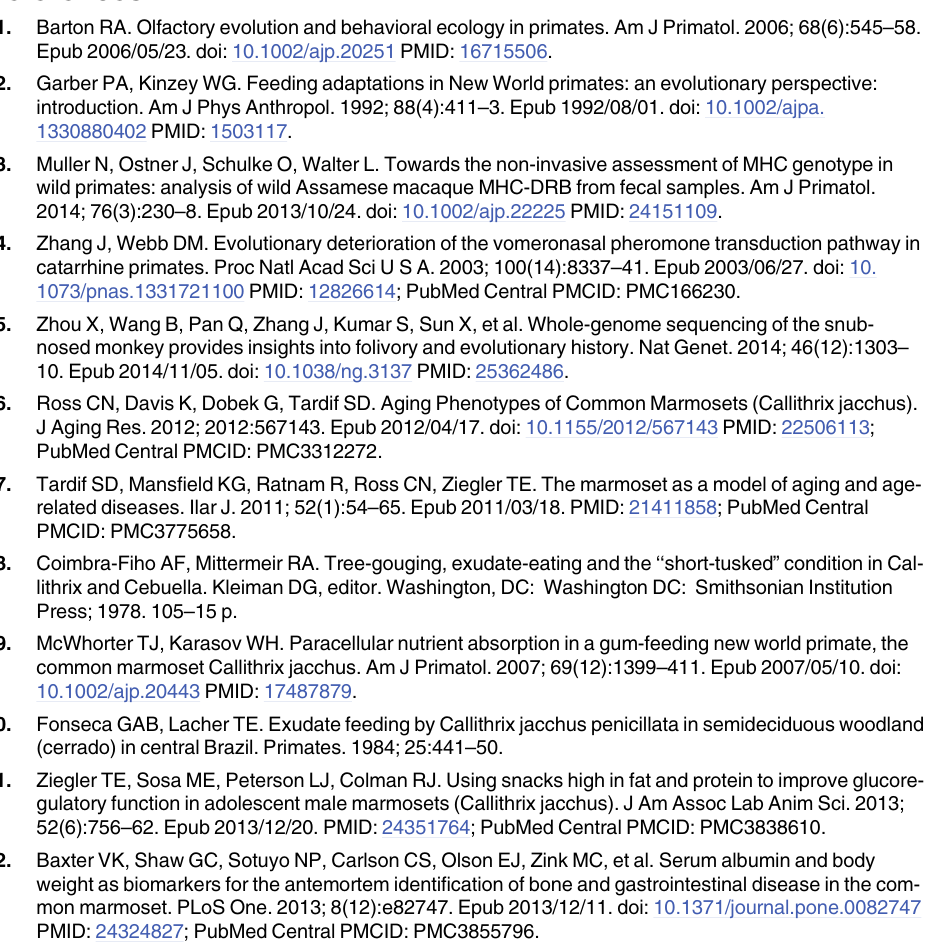
S1 Table. Metabolomics data of 50 common marmosets. Plasma collected from marmoset was analyzed for metabolomics by high-resolution mass spectrometry as described in Methods. The mass spectrometry data includes ion mass (mass to charge, m/z ), retention time (sec) and abundance (intensity) of 58 metabolites. The information of sex and age on 50 individuals is indicated on